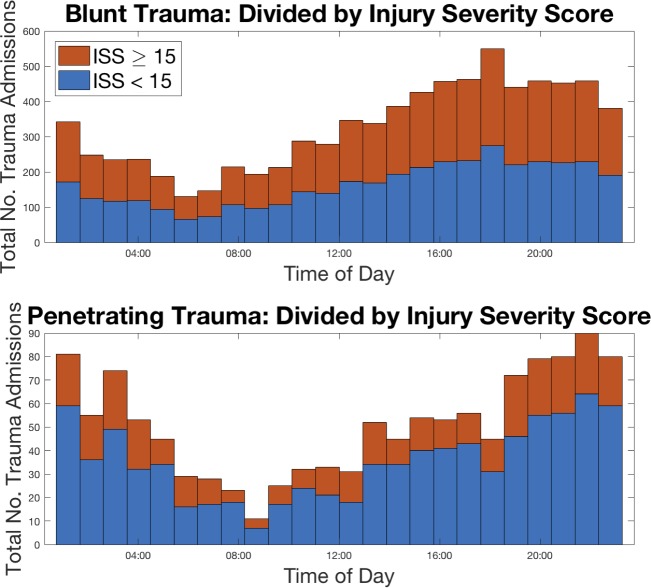
Absolute frequency of trauma admissions versus time of day partitioned by blunt and penetrating and divided by injury severity score.